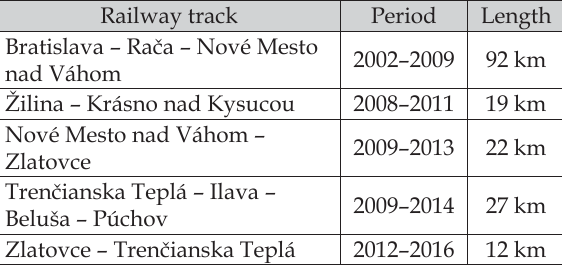
Fig. 3. TEN-T Core Network Corridors in the railway network of Slovakia. Source: own elaboration. Table 1. Modernisation of railways in Slovakia for the speed of 160